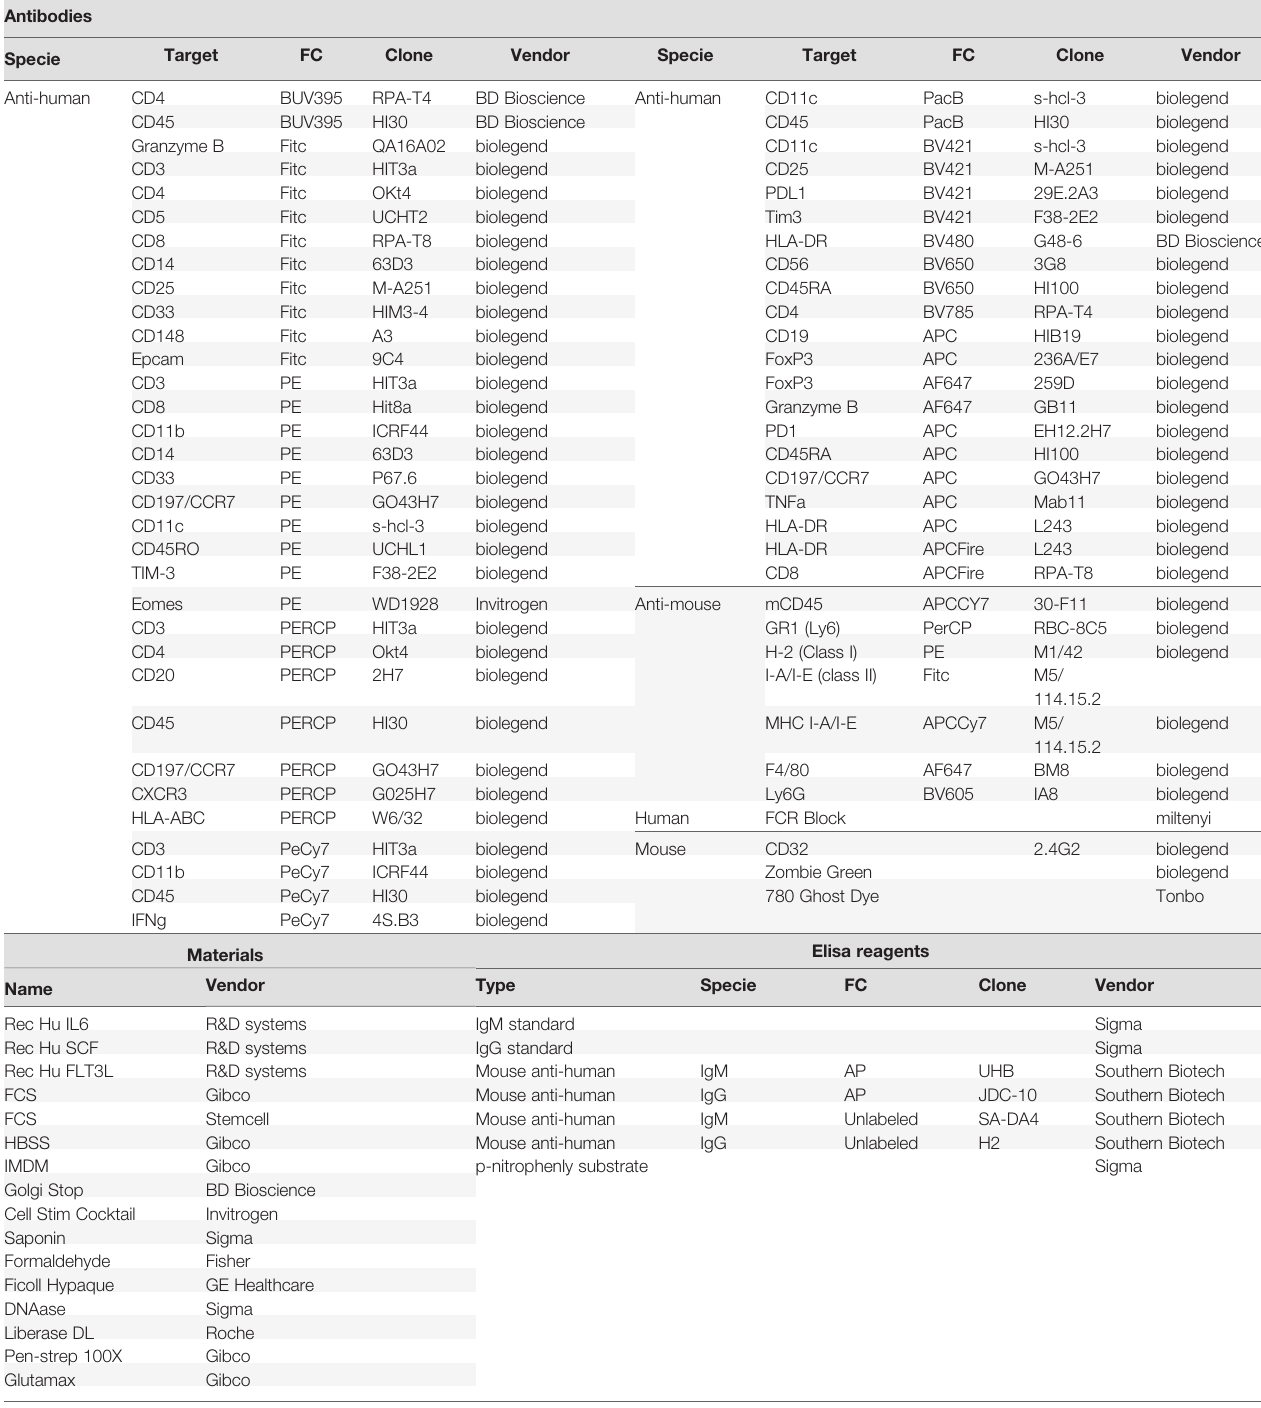
TABLE 1 | Flow cytometry antibodies and reagents. Antibodies